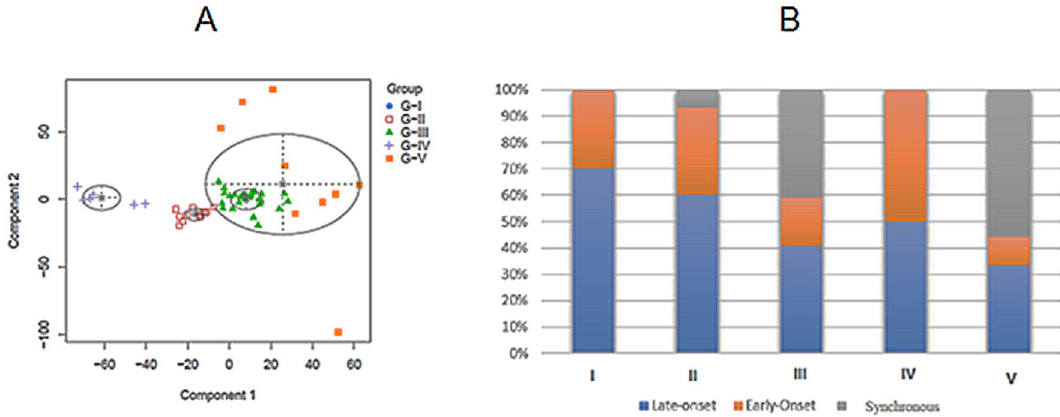
Figure 1. Genomic alteration clustering for rectal cancer cases. ( A ) Grouping of rectal cancers with the MClust method (https ://mclus t-org.githu b.io/mclus t/). ( B ) Distribution of rectal cancers within the five groups from the MClust analysis.